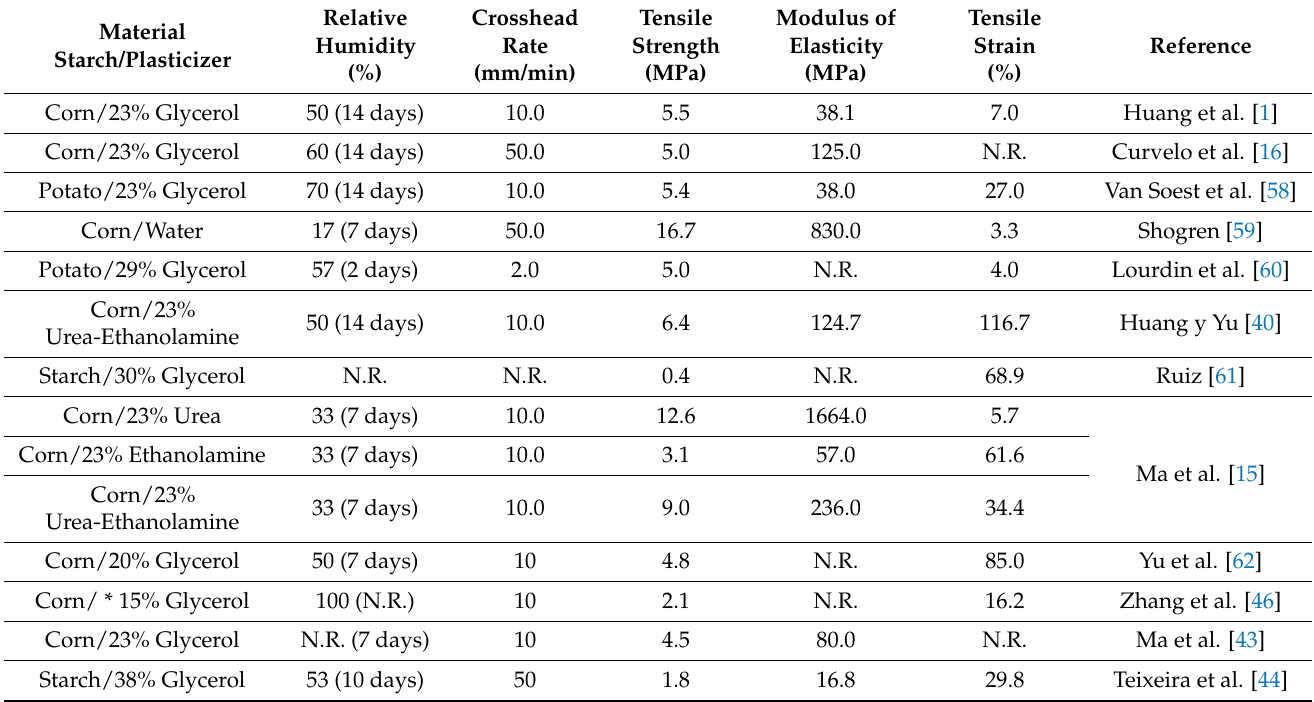
Table 4. Tensile mechanical properties of different TPS samples under different storage conditions. Percentage calculated with respect to the total mass (plasticizer + starch).